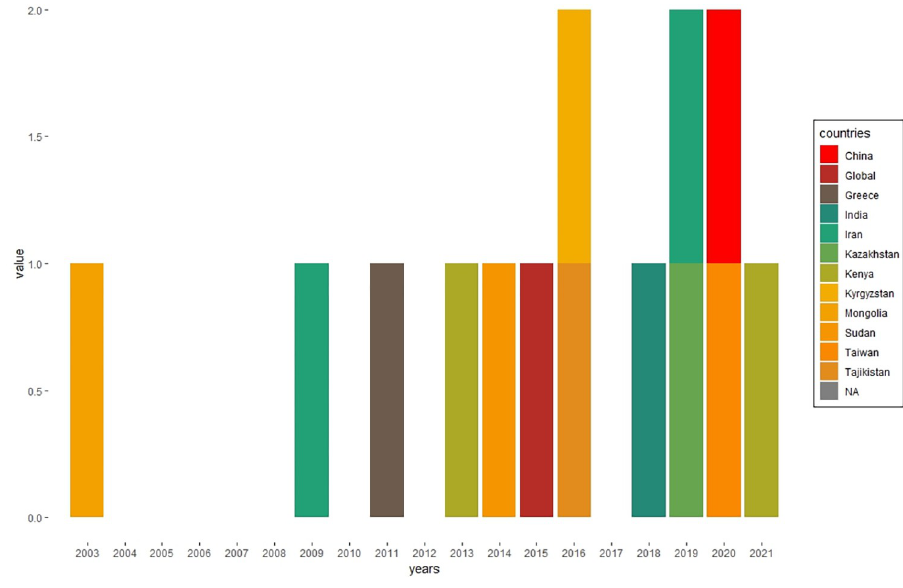
Fig 3. Existing Brucella burden of disease studies by year of